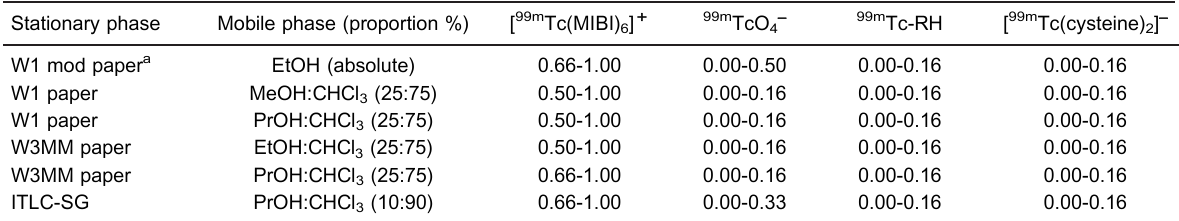
Table 2. Retention factor (Rf) for [ 99m Tc(MIBI) 6 ] + and possible impurities obtained in their preparation, for several chromatographic systems. Stationary